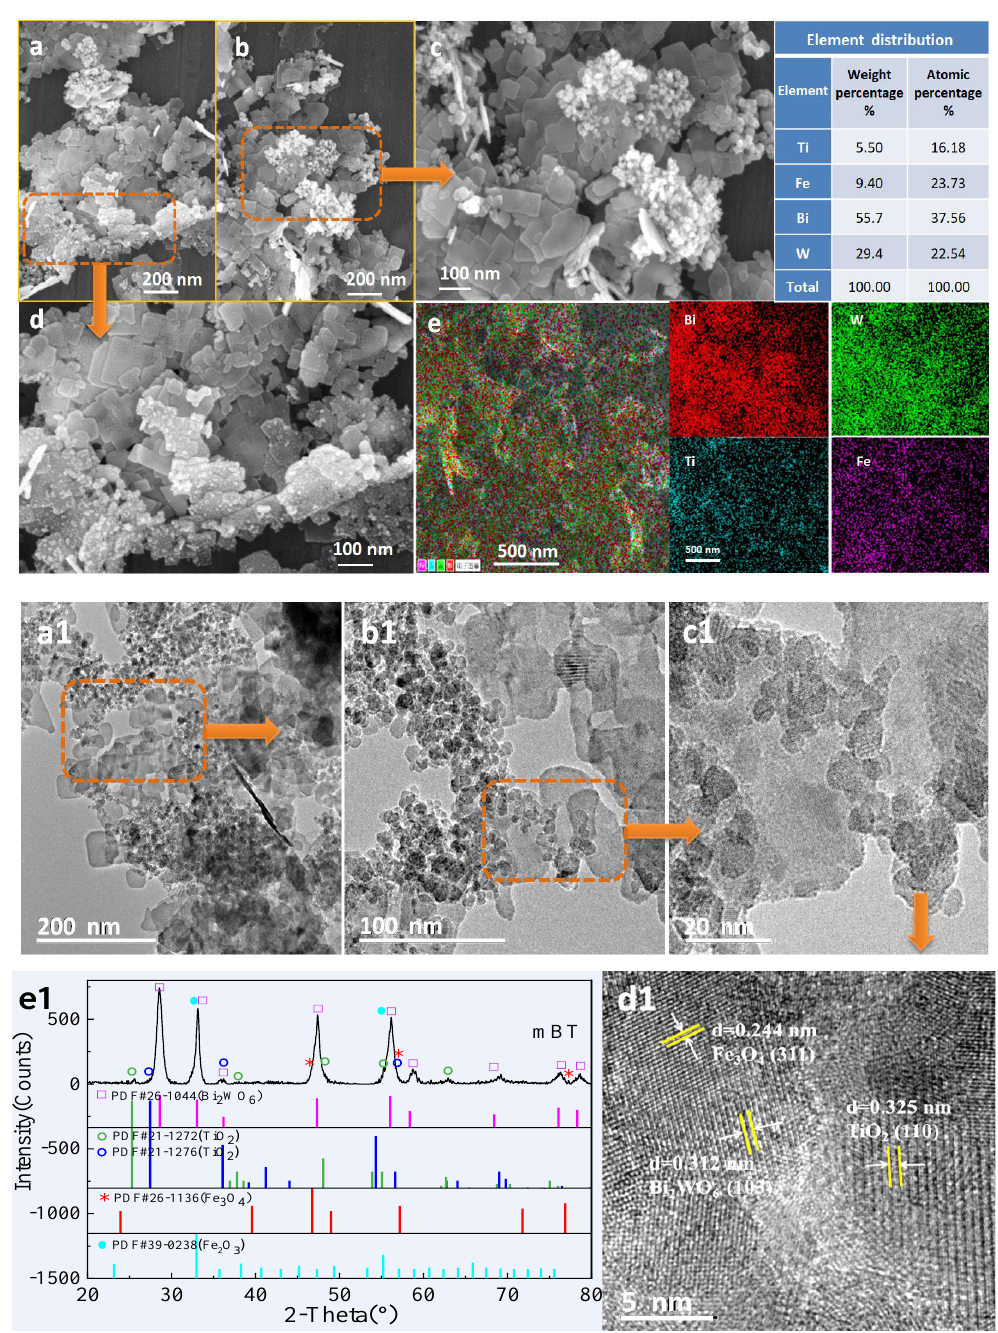
Figure 2. The SEM image ( a – d ) and EDS mapping of mBT ( e ); the HRTEM image ( a1 – c1 ) and the lattice marking ( d1 ) of mBT; and the XRD image of mBT ( e1 ). Bi 2 WO 6 was assembled from a large number of irregular two-dimensional nano- sheets with a length of 20 nm to 120 nm, and TiO 2 (25 nm) and Fe 3 O 4 (6 – 12 nm) particles were distributed on its surface. Some particles were distributed on the two-dimensional Bi 2 WO 6 surface as fish eggs due to magnetism, as shown in Figure 2c. Some particles combined well with Bi 2 WO 6 and formed a stable heterojunction, as shown in Figure 2d. The element layering image of the composite was shown in Figure 2e, which was composed of Bi, W, Ti, and Fe elements; no other elements were detected, which was consistent with the characterization results of X-ray diffraction and X-ray photoelectron spectroscopy, further proving the successful preparation of mBT. Analyzing the HRTEM images of Figure 2(a1 – c1), TiO 2 and Fe 3 O 4 nanoparticles were embedded in Bi 2 WO 6 nanosheets. The Bi 2 WO 6 lattice, TiO 2 lattice, and Fe 3 O 4 lattice of this composite material are shown in Figure 2(d1). The crystal structure of the prepared samples was further understood by an X-ray diffractometer. The strong and sharp diffraction peaks showed that the prepared samples had high crystallinity. The X-ray diffraction spectrum of the composite material mBT is shown in Figure 2(e1). This composite material, mBT, havs diffraction peaks at 2θ = 28.6, 33.0, 47.3, and 56.0°, which correspond to the crystal planes of (103), (200), (220), and (303) of Bi 2 WO 6 (JCPDS26-1044). The diffraction peaks at 2θ = 25.3 27.4, 36.1, 37.8, 48.0, 54.3, and 62.7° correspond to the crystal planes of (101), (110), (101), (004), (200), (211), and (204) of TiO 2 (JCPDS21-1276) and (JCPDS21-1272), respectively. The diffraction peaks at 2θ= 46.77, 57.18, and 76.88° correspond to the crystal planes of (311), (440), and (511) of Fe 3 O 4 (JCPDS26-1136), indicating the successful preparation of mBT photocatalyst. 3.1.2. Elements and Valence States Analysis The chemical composition and electronic state of the mBT visible light photocatalyst were analyzed by XPS. As the results shown in Figure 3a indicate, the full spectrum indicates the material is mainly composed of bismuth, tungsten, oxygen, titanium, and iron. The presence of a C1S peak may be due to carbon dioxide in the air. Figure 3b – f shows the high-resolution XPS spectra of each element of the material. The peaks at 158.73 eV and 163.96 eV (Figure 3b) are attributed to Bi4f 7/2 and Bi4f 5/2 , respectively, which are the characteristics of Bi 3+ ions in Bi 2 WO 6 . The binding energies of the two peaks are 34.89 eV and 36.78 eV, respectively, (Figure 3c), which belong to W4f 5/2 and W4f 7/2 , indicating that W exists in the form of +6 valence in this material. In Figure 3d, the two peaks of 458.22 and 465.47 eV correspond to Ti2p 3/2 and Ti2p 1/2 , respectively. As shown in Figure 3e, the two peaks at 710.88 and 723.4 eV correspond to Fe2p 3/2 and Fe2p 1/2 , respectively. The existing forms of Fe are FeO and Fe 2 O 3 , indicating the existence of Fe 2+ and Fe 3+ in the